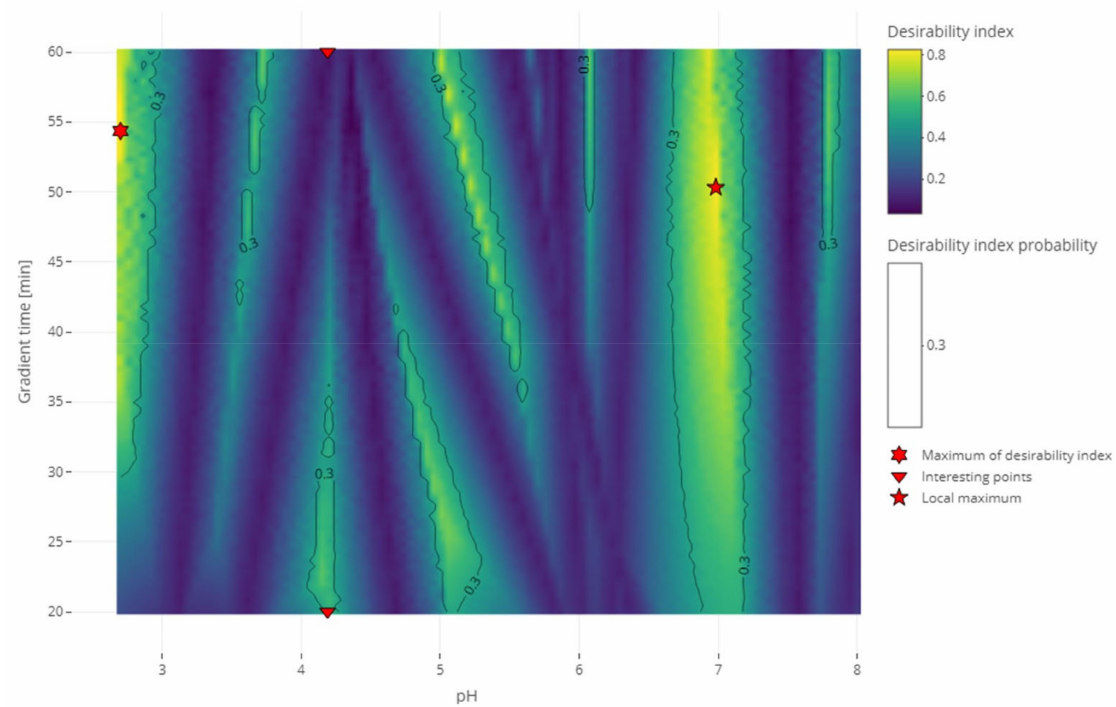
Figure 5. Heatmap of the desirability index in function of the pH and the gradient time calculated with the relative weights of 1 for the separation criterion, 0.5 for the sensitivity to experimental parameters criterion, and 0.1 for the analysis time criterion. The black contour line delimits the regions where there is a probability of 30% or more to reach the desirability index of 0.5. The hexagram shows the condition with the highest desirability index. The five-branch star shows the condition with the highest desirability index inside the largest region. The triangles are interesting points to evaluate the effect of gradient